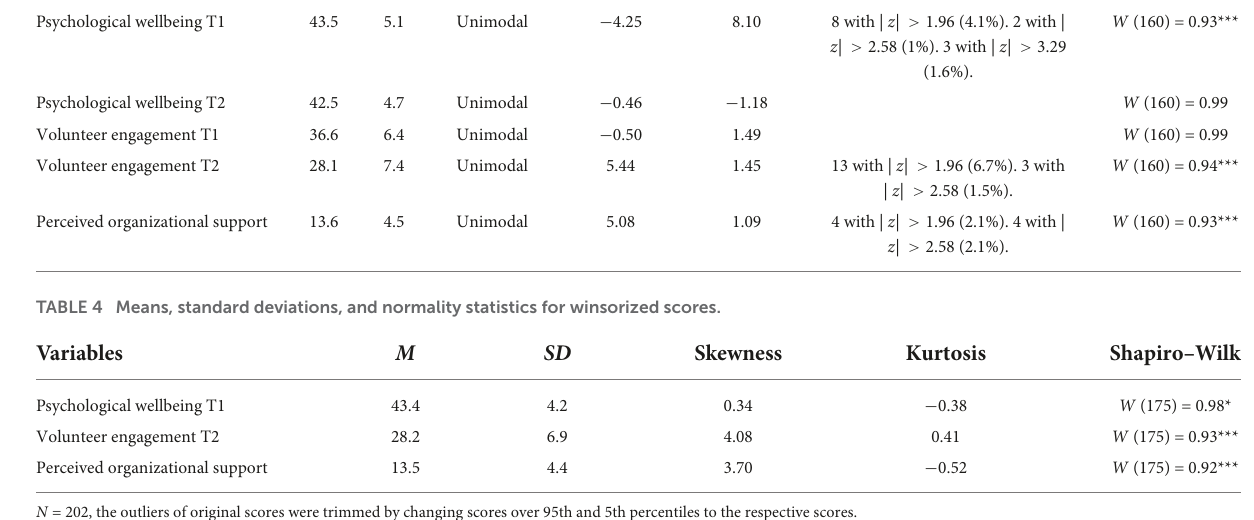
TABLE 3 Summary table of normality assessment for variables. Variables SD